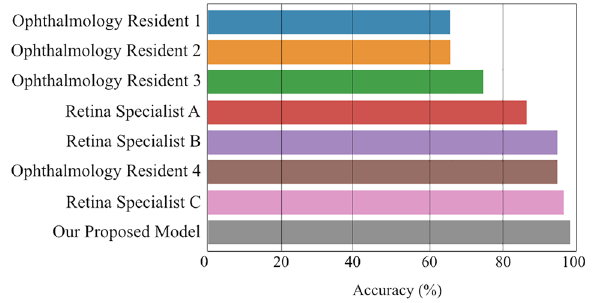
Figure 1. Performance comparison between ophthalmologists and the proposed model. This figure shows the accuracy between the ophthalmologists and the proposed model in distinguishing different CSC subtypes. Our